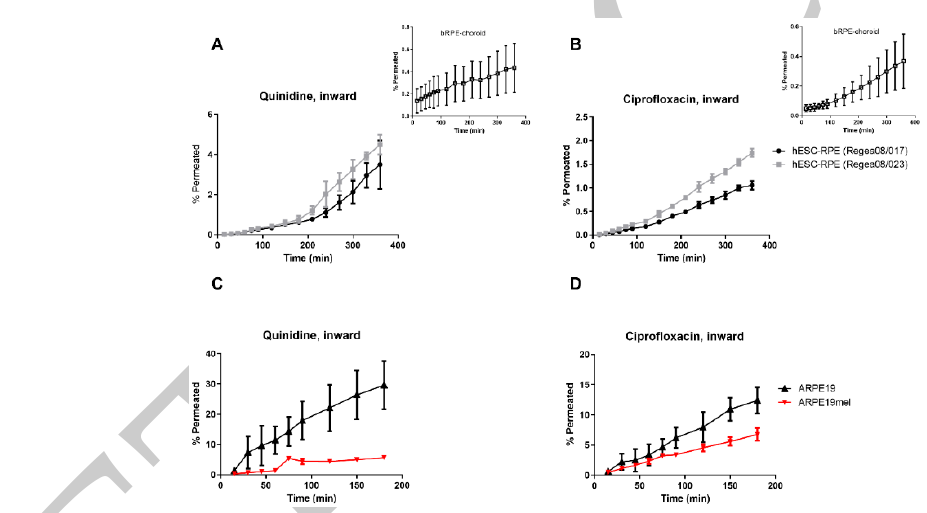
Figure 2. Two high melanin-binders, quinidine and ciprofloxacin, display melanosomal accumulation in pigmented hESC-RPE and ARPE19mel cells. ( A ) Quinidine had a lag time of approximately 200 min in its permeation across the hESC-RPE cell layers, but no clear lag time was evident in bovine RPE-choroid (inset). ( B ) A permeation lag-time of approximately 100 min was detected for ciprofloxacin in hESC-RPE cells, which was similar to that present in bovine RPE-choroid (inset). Flux profiles of ( C ) quinidine and ( D ) ciprofloxacin di ff ered between the non-pigmented ARPE19 and re-pigmented ARPE19mel cells. Number of replicates: ARPE19 and ARPE19mel, n = 3; hESC-RPE cells, n = 5; bovine RPE-choroid, n = 5 (quinidine) and n = 8